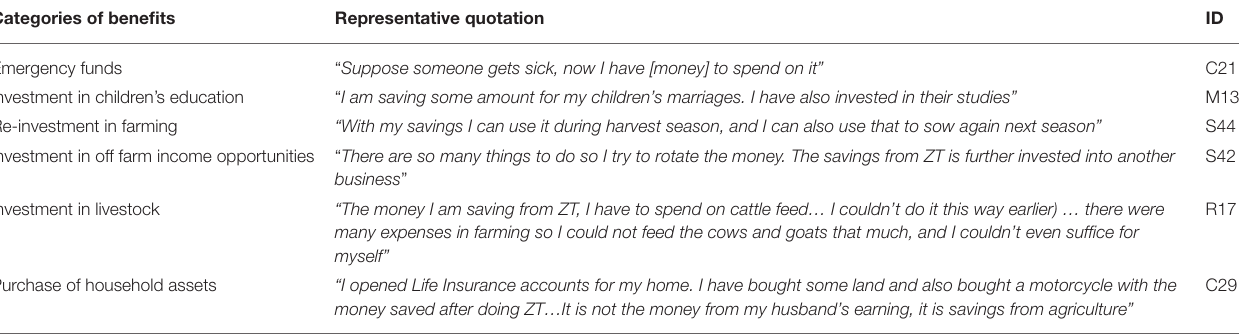
TABLE 2 | Financial benefits and implications for farmers as experienced through CASI